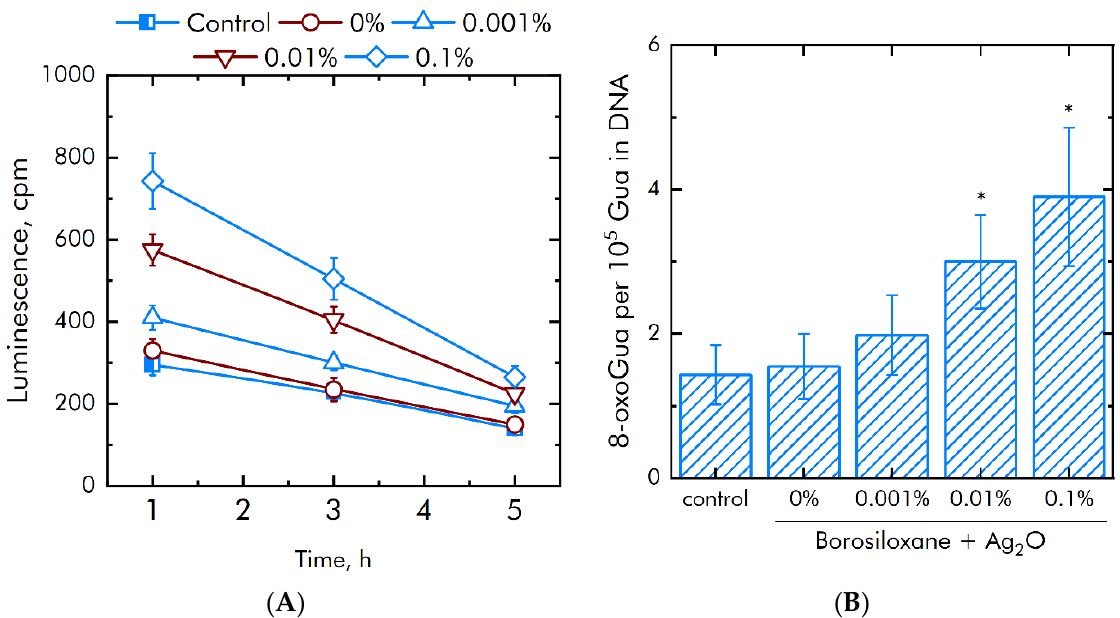
Figure 9. Effect of BS and composition Ag 2 O NPs·BS on markers of proteins and DNA damage generation. ( A )—Production of long-lived reactive protein species. ( B )—Production of 8-oxoGua. *— p < 0.05 versus control. Data are shown as means ± SEMs.